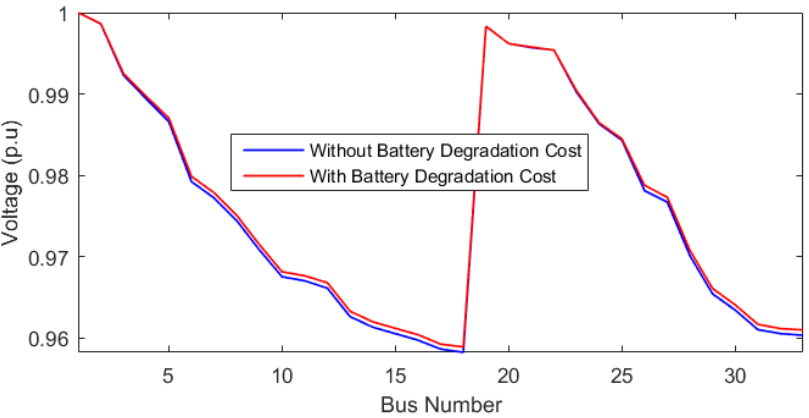
Figure 15. Minimum voltage of the 33-bus distribution network without and with battery degra- dation cost using the IGJO during 24 h.